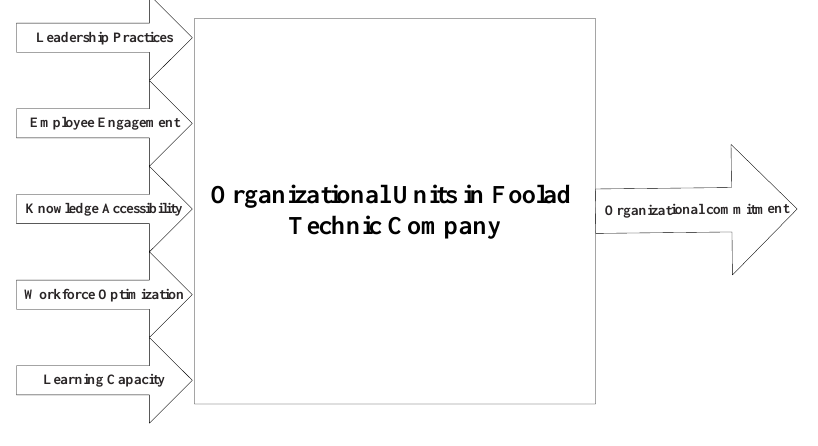
Figure 3. DEA model in case study